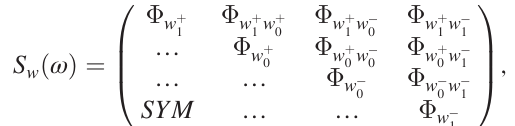
quadrupoles.TABLE FIG. 3. Transfer functions between the ground and the